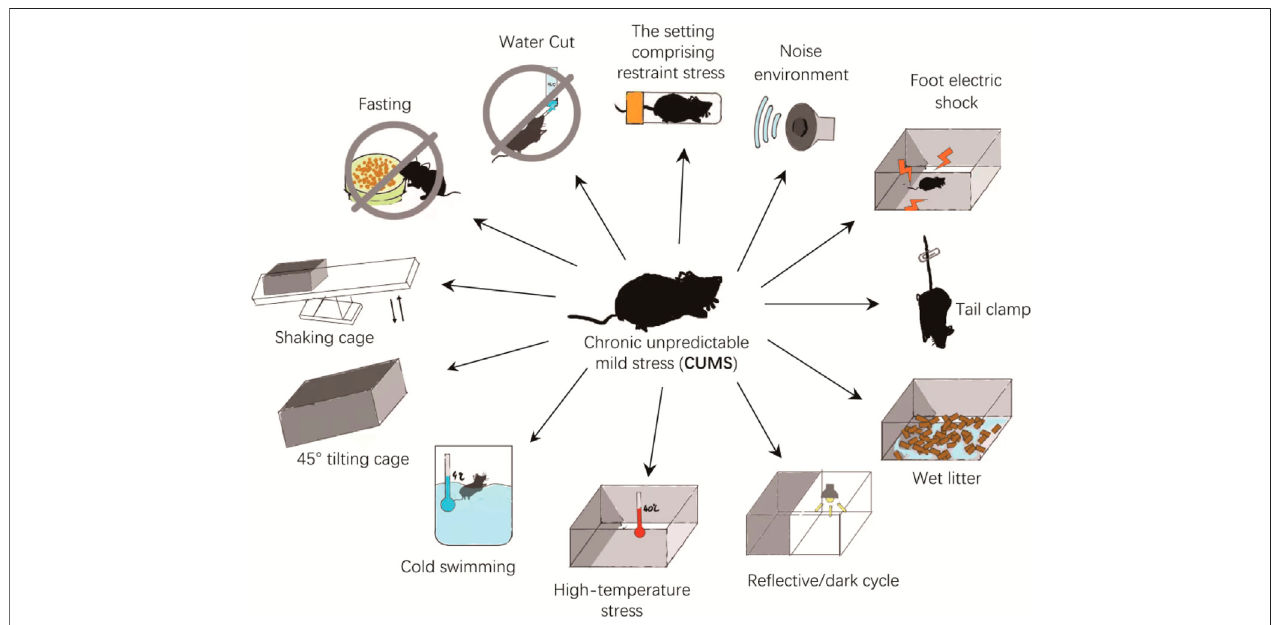
FIGURE 2 | The CUMS animal